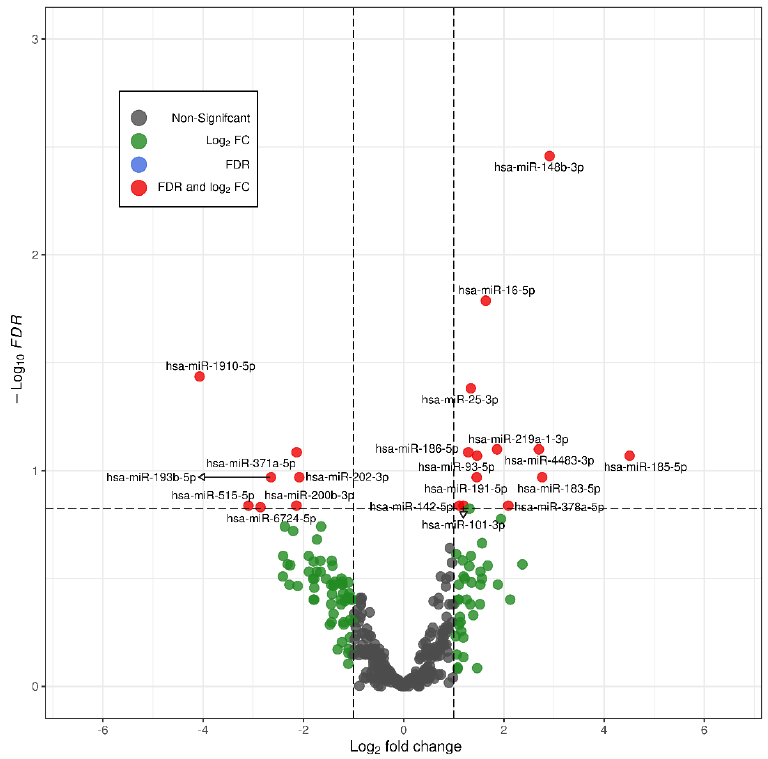
Figure 1. Volcano plot showing miRNA overexpression in LO-FGR fetuses. Vertical lines represent the log FC thresholds at −1 and 1, while the horizontal line represents the FDR threshold at 0.15.